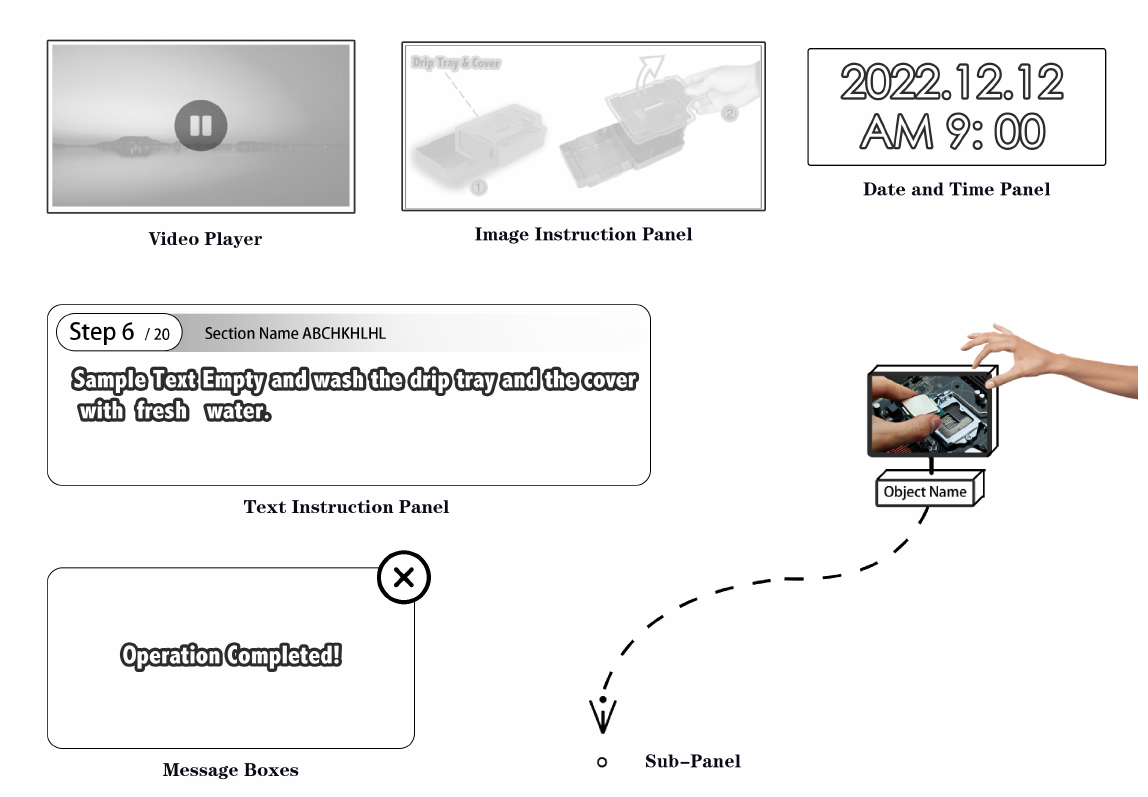
Figure 6. Informational